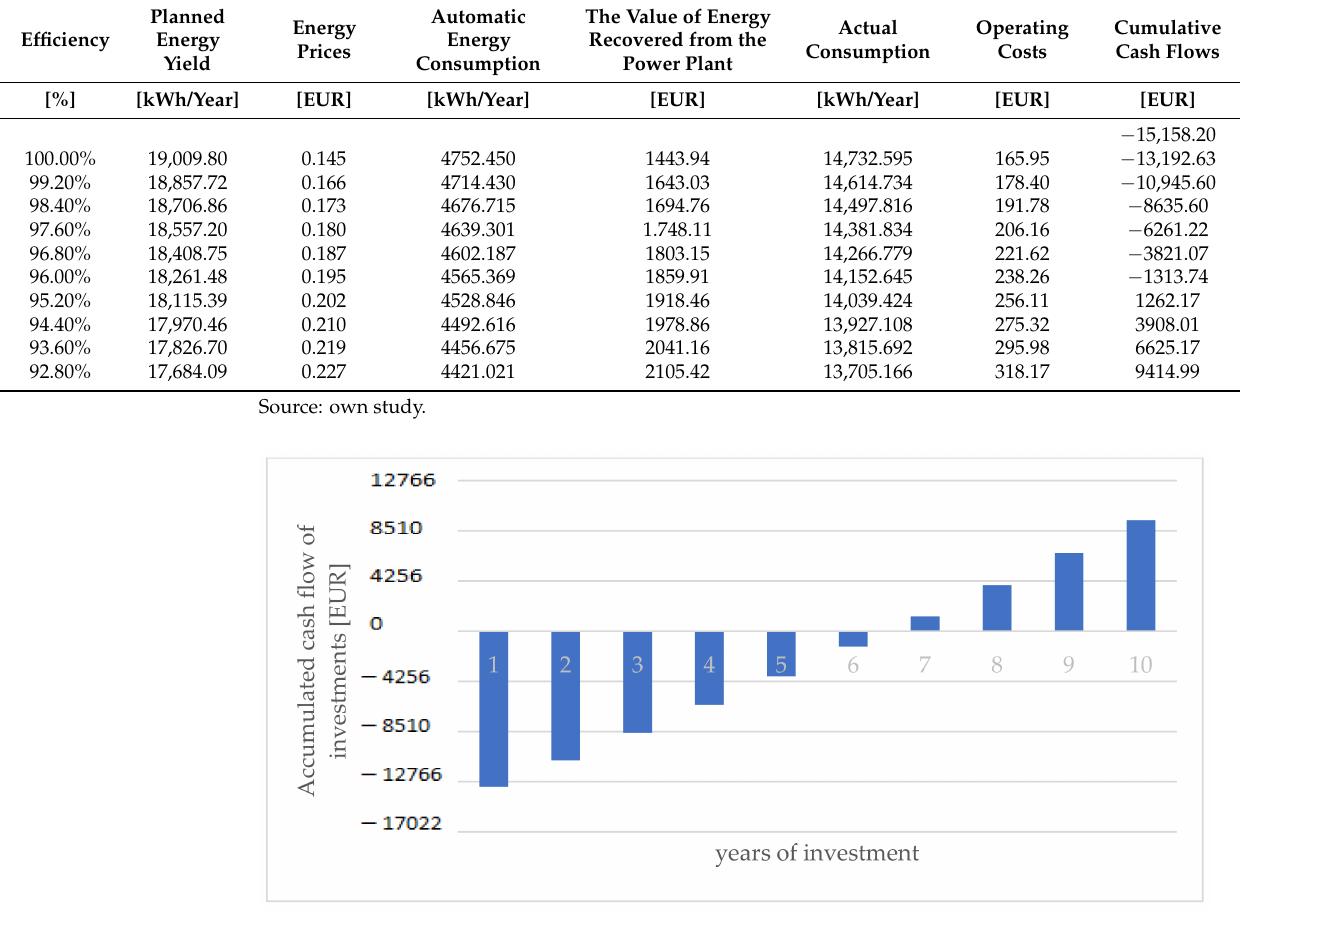
Figure 4. Cumulative cash flows for a heat pump investment with a PV plant. Source: own